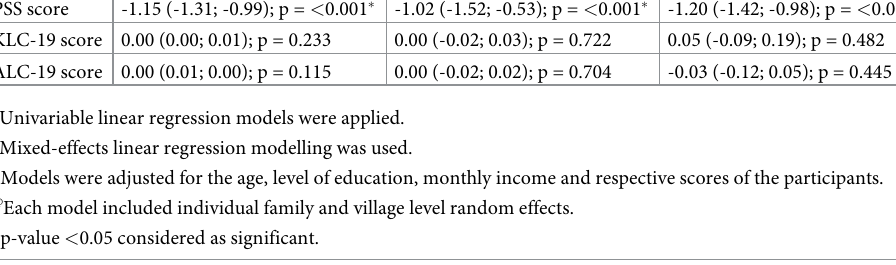
Table 5. Effect of change in FIES score from wave 1 to wave 2 on PSS, KLC-19 and ALC-19 scores. List of Scores Individual level Model #